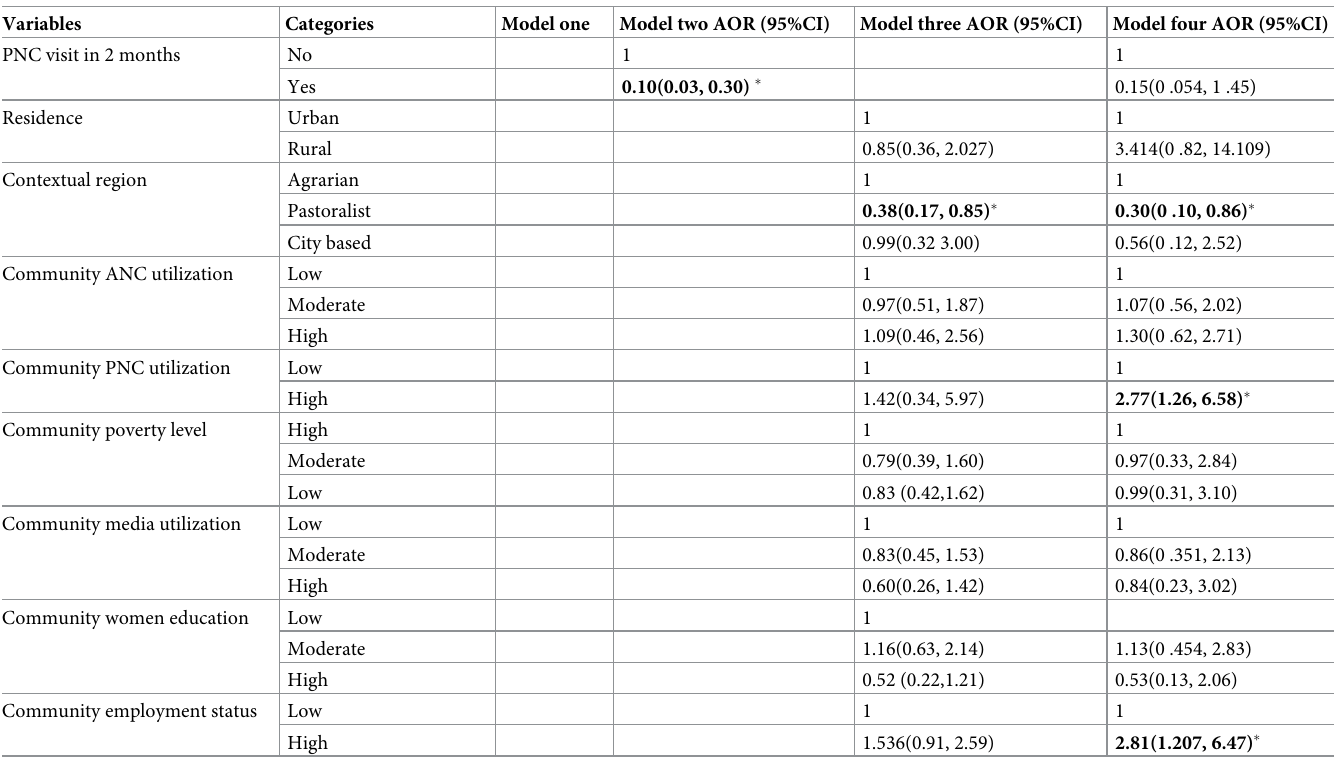
Infant comorbidities were negatively associated with exclusive breastfeeding. Those infants who had comorbidities were 66% [AOR = 0.34, 95%CI: (0.21, 0.57)] less likely to exclusively breastfeed as compared to infants who had no comorbidities. Household wealth index was positively associated with exclusive breastfeeding. Those infants from the richest family wealth index were 10 times [AOR = 10.34, 95% CI: (3.14, 34.03)] more likely exclusive breastfeeding as compared to those infants from the poorest fam- ily wealth index. The maternal antenatal visit was also positively associated with exclusive breastfeeding. Those infants whose mothers had ANC visits were 2.25 times [AOR = 2.25, 95%CI: (1.323, ANC